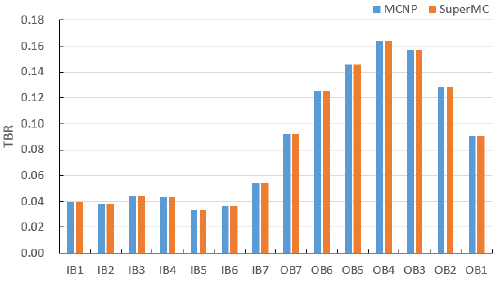
Figure 6. Distribution of TBR in blankets